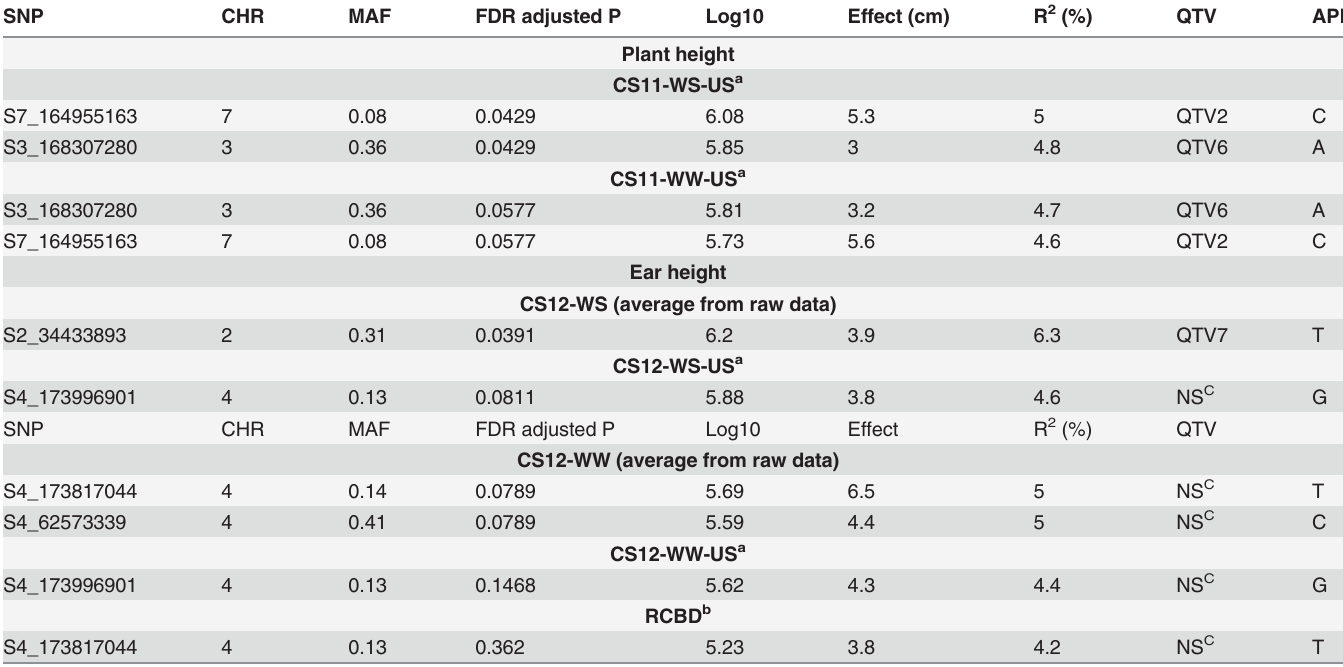
Table 10. GWAS results for plant and ear height (cm).